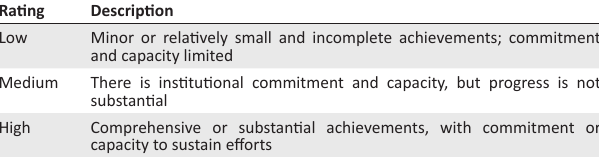
TABLE 1: Criteria for rating the use of the indicators of the Hyogo Framework for Action in